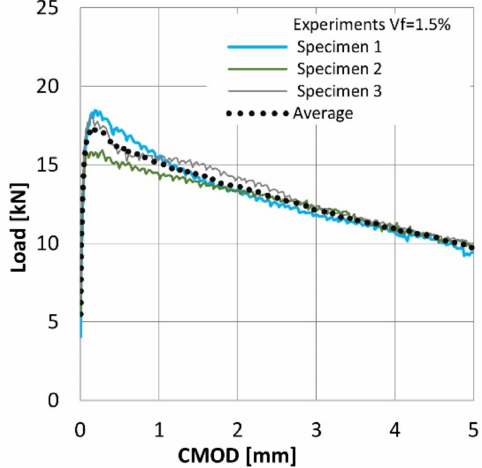
Figure 6. Load-CMOD curves for three specimens reinforced with 1.5% of recycled steel fibers (RSF).